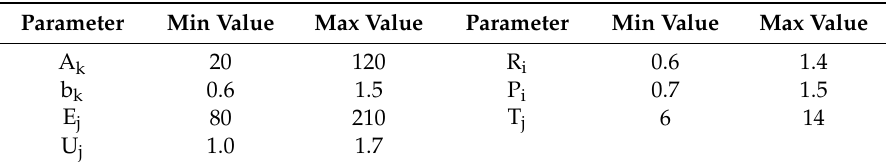
Table 11. Values of parameters.